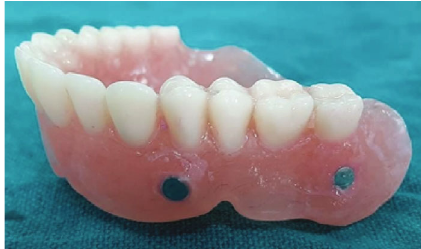
Figure 6: Maxillary denture with cheek plumper prosthesis (frontal view and intaglio surface).